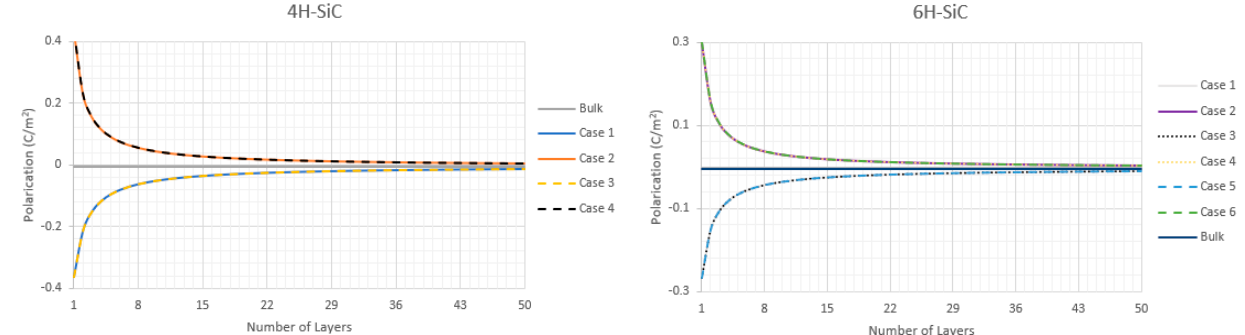
Figure 6. P sp as a function of the number of periodic layers for 4H-SiC and 6H-SiC.